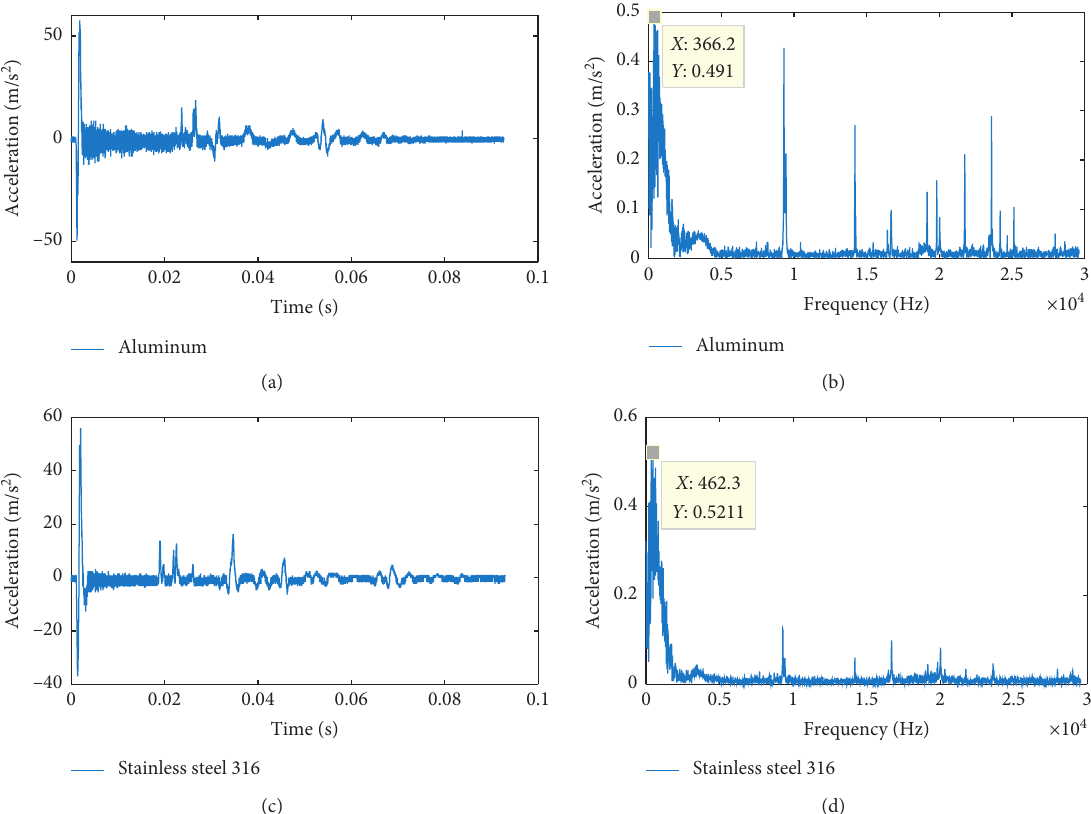
Figure 6: (a) Time-domain waveforms of aluminum, (b) spectrum of aluminum, (c) time-domain waveforms of stainless steel 316, and (d) spectrum of stainless steel 316.